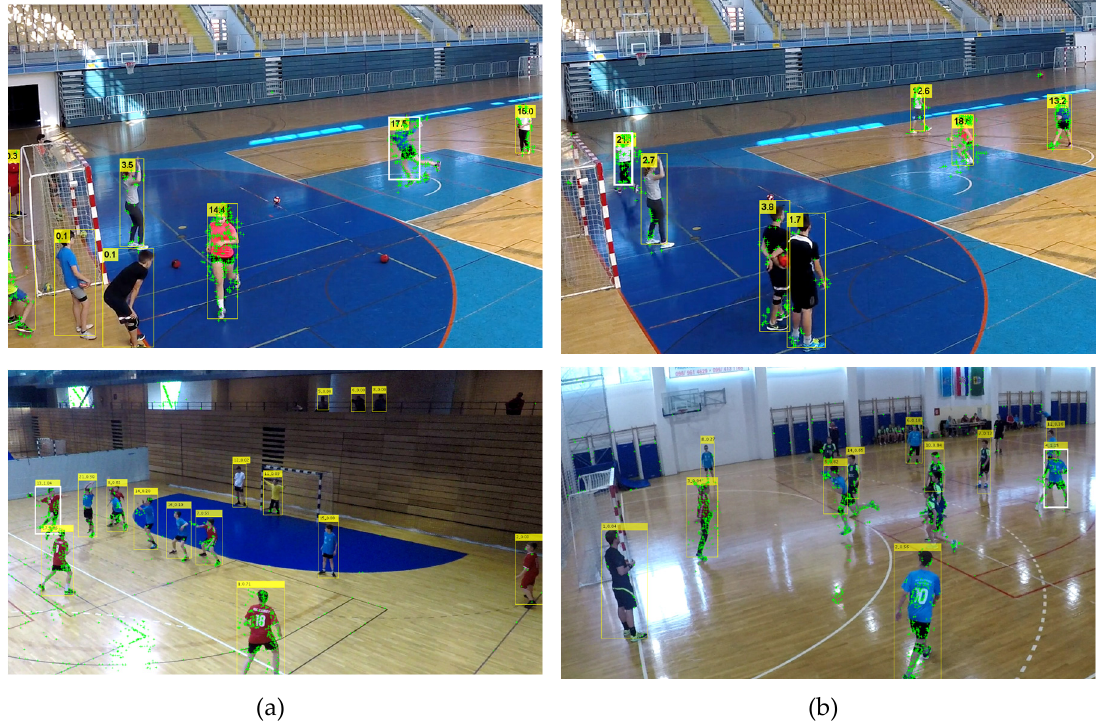
Figure 14. Marking of the leading player (white thick bounding box); ( a ) Correct detections; ( b ) Wrong detections. Examples were taken in di ff erent handball halls and under di ff erent indoor and outdoor lighting